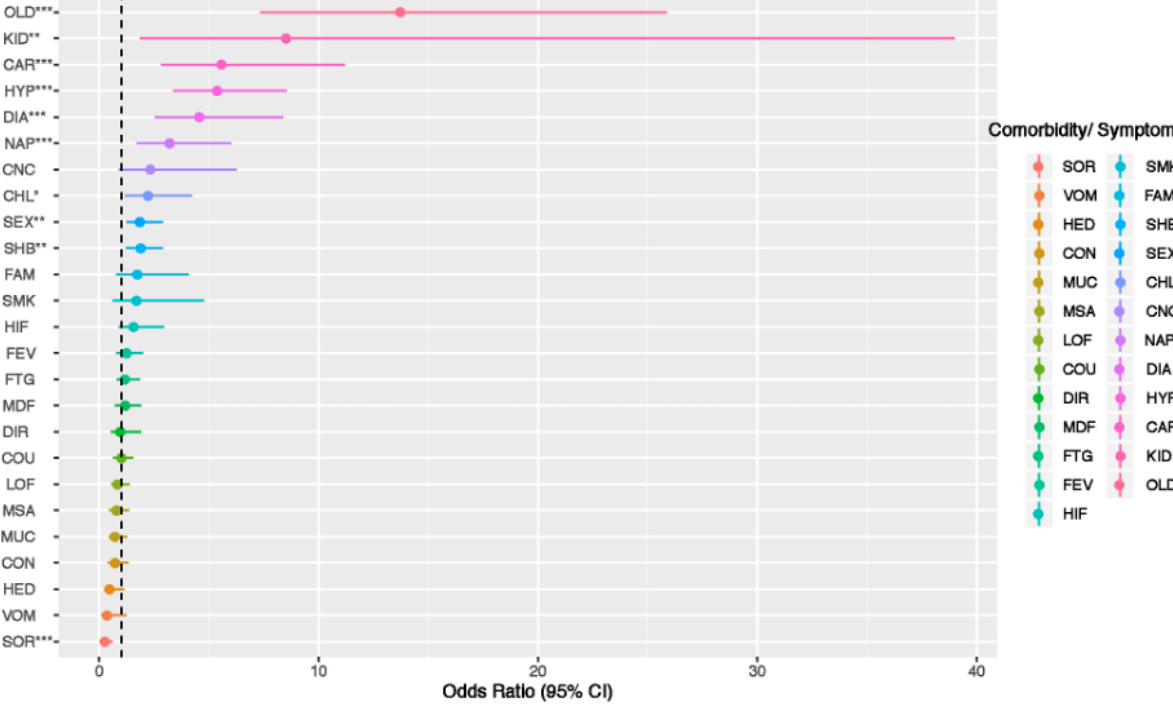
Figure 2. Forest plot of the importance of clinical features of patients with nonsevere and severe clinical types of COVID-19. Chronic obstructive pulmonary disease is not included because only patients with severe COVID-19 showed it as a comorbidity. The threshold for a feature to be positively or negatively associated with severe COVID-19 was 1 (dashed line), not 0. CAR: cardiovascular disease; CHL: chills and shaking; CNC: cancer; CON: contact with patients with COVID-19; COU: coughing; CPD: chronic obstructive pulmonary disease; DIA: diabetes; DIR: diarrhea; FAM: family members with COVID-19; FEV: fever; FTG: fatigue; HED: headache; HIF: high fever; HYP: hypertension; KID: renal disease; LOF: low fever; MOF: medium fever; MSA: muscle ache; MUC: phlegm; NAP: loss of appetite; OLD: older age; SEX: male sex; SHB: chest congestion; SMK: history of smoking; SOR: sore throat; VOM: vomiting. * P <.05, ** P <.01; *** P <.001 from the 2×2 contingency table for each